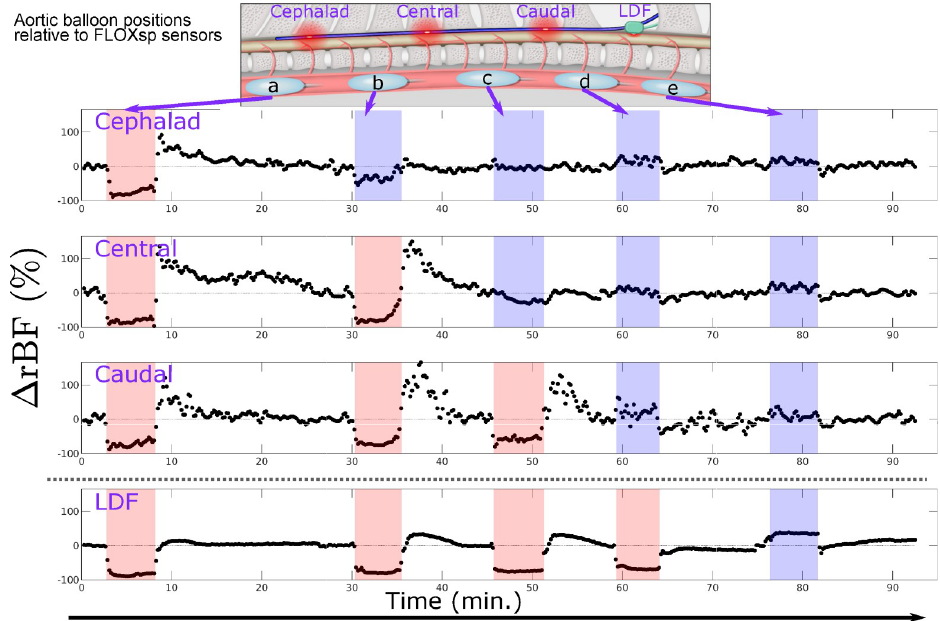
Fig 6. Time course of blood flow changes during serial aortic balloon inflation and occlusion. The balloon was moved from cephalad to caudal locations (schematic, inset), measuring at three different sites with DCS (cephalad, central, and caudal) and one site with LDF. Shaded regions indicate that the aortic balloon was inflated. Red (blue) shading indicates the balloon was cephalad (caudal) to the measurement site. As discussed in the text, a cutoff of Δ rBF = -30% permitted localization of the balloon inflation relative to the DCS measurement sites, i.e., ’above all’ (a), ’between cephalad and central’ (b), ’between central and caudal’ (c), and ’below all’ (d, e). In situations where the sensor position was only slightly cephalad to the balloon, we occasionally observed slight decreases (e.g., cephalad sensor near minute 30) and increases (e.g., caudal DCS near minute 60). This effect may be due to the precise local vascular anatomy and degraded the accuracy of localization. Anecdotally, we observed smaller increases in blood flow following balloon deflation with LDF, although this reactivity was not the focus of our study.